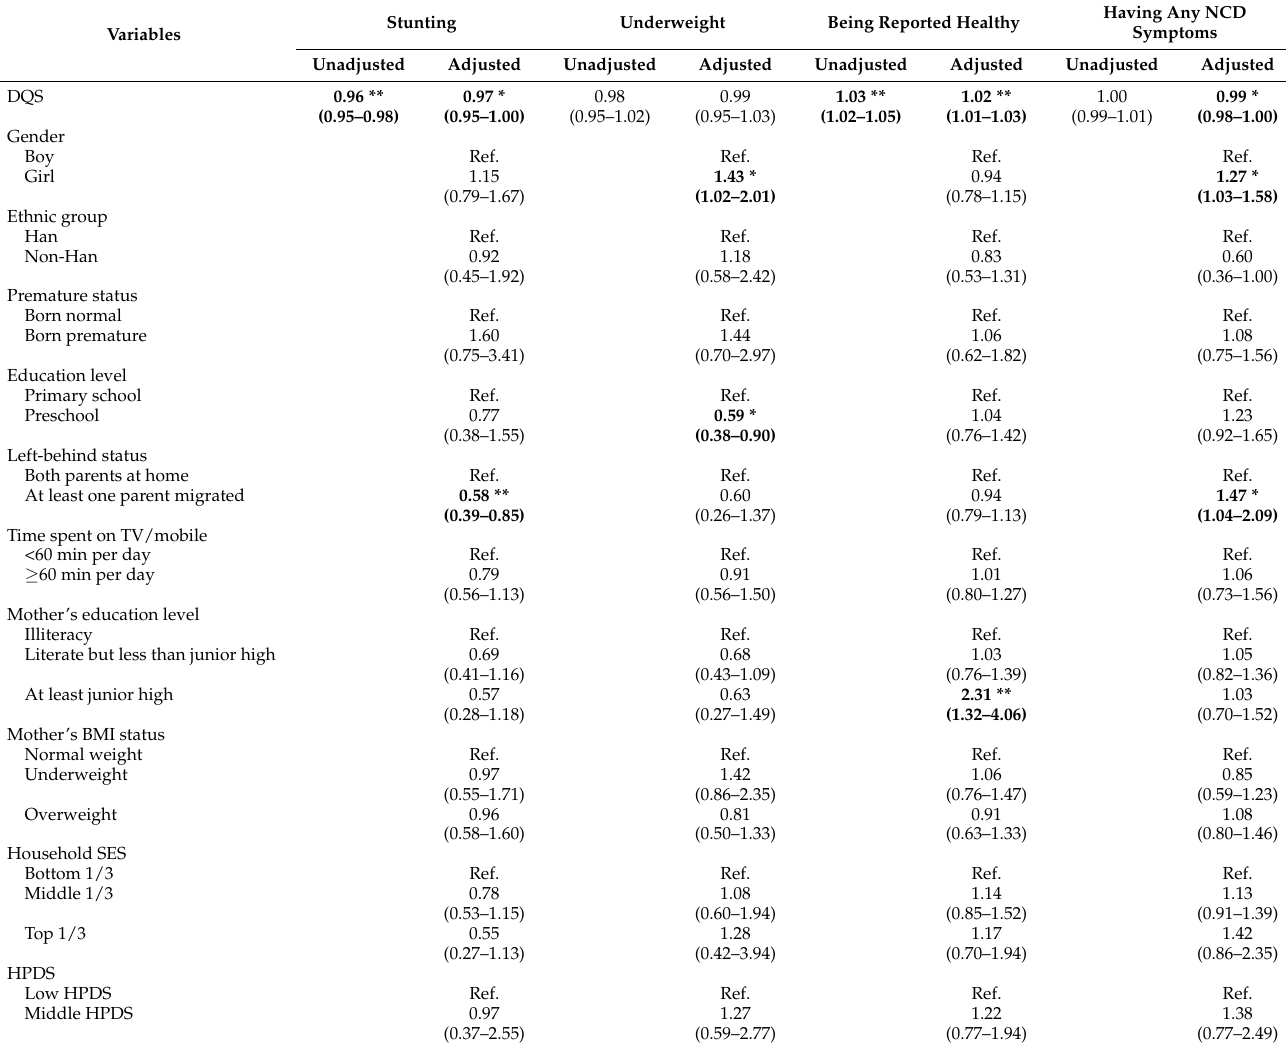
Table 3. Association between DQS and health outcomes, OR (95%